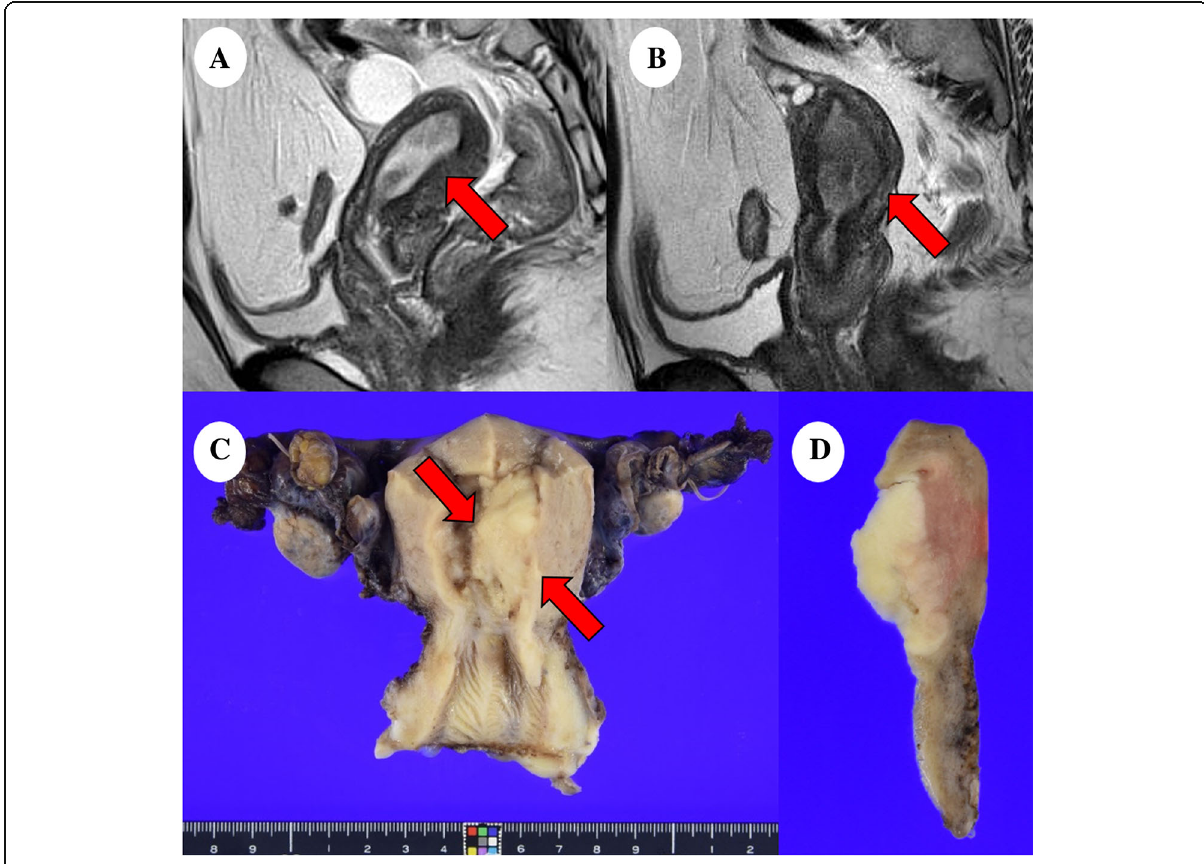
Fig. 1 Magnetic resonance imaging and macroscopic analysis: ( a ) T2-weighted image of the initially diagnosed tumor (red arrow). ( b ) T2- weighted image of the recurred tumor (red arrow). ( c ) The endometrial mass (red arrows) was 40 × 23 mm-sized in the left wall of the uterine body and ( d ) had yellow-whitish cut